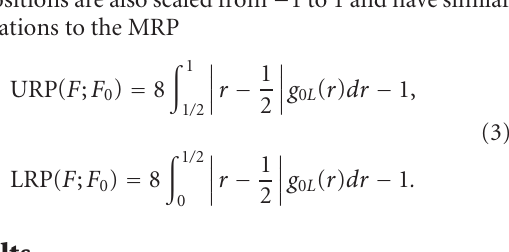
Abbreviations: NH = Non-Hispanic. Data from the National Health and Nutrition Examination Survey.